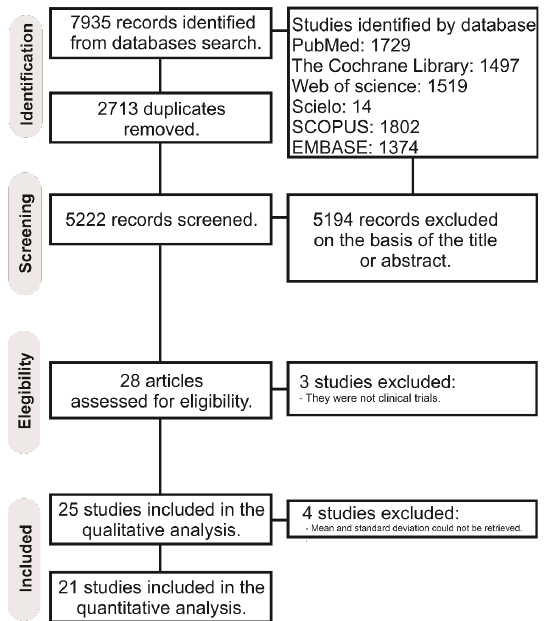
Figure 1. PRISMA